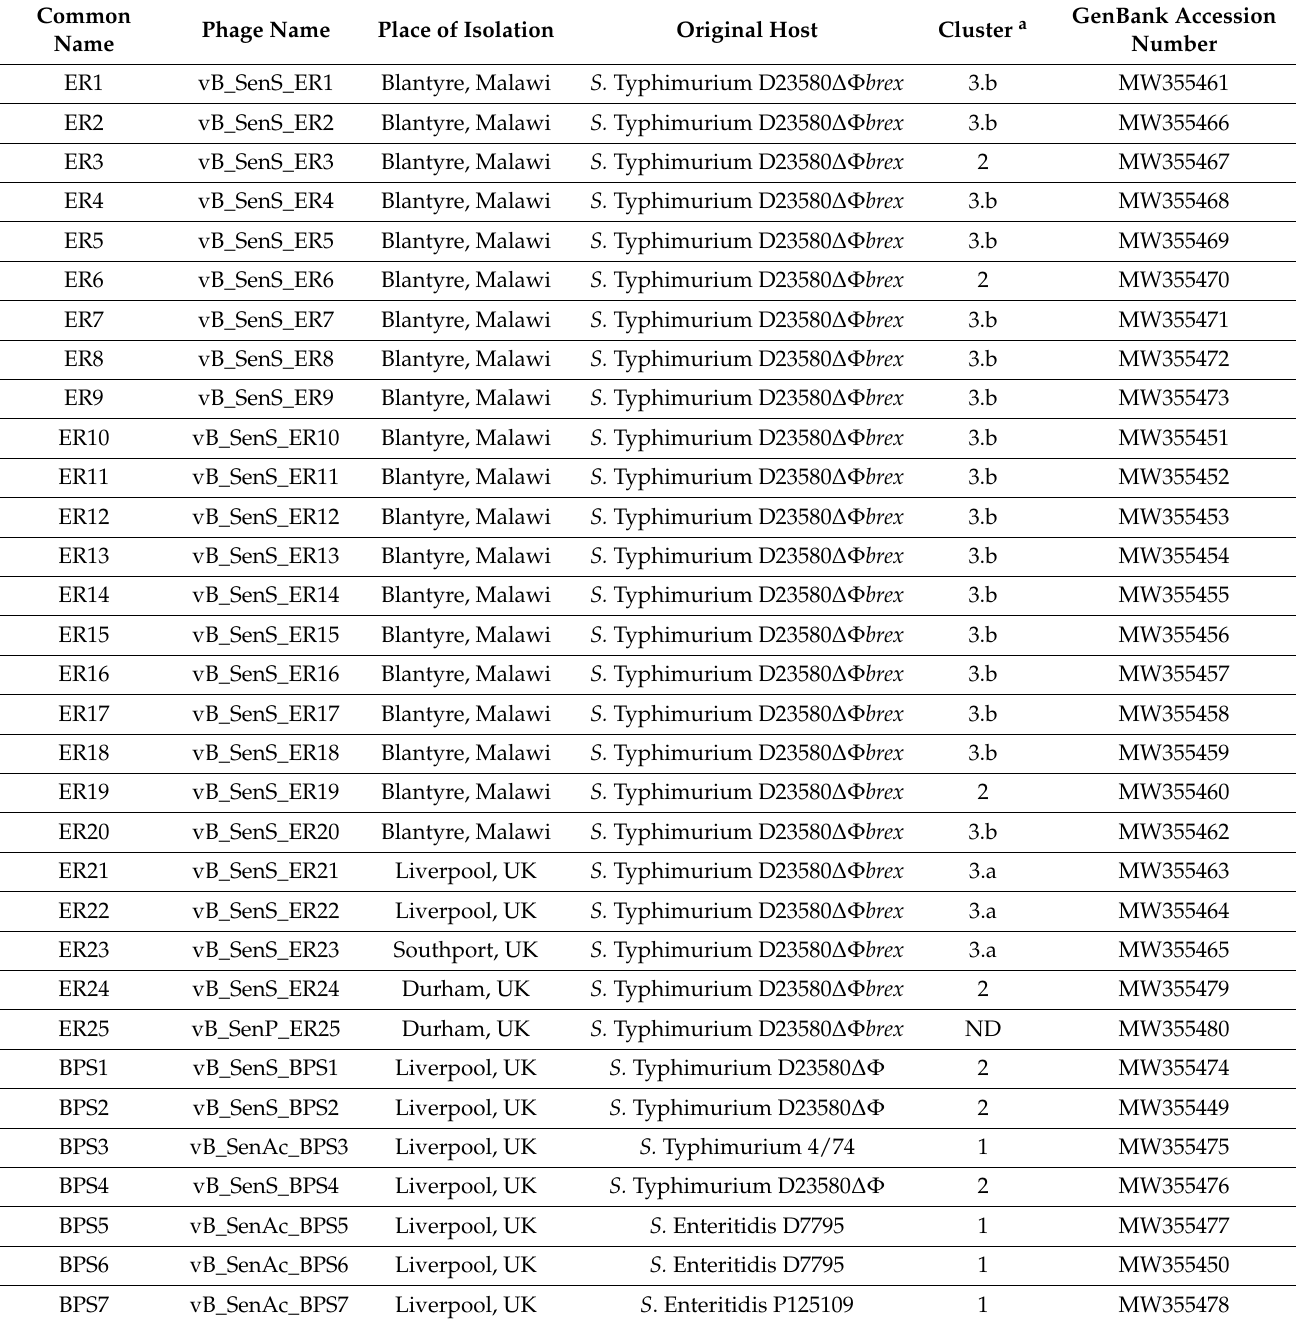
Table 2. Salmonella phages isolated in this study and associated